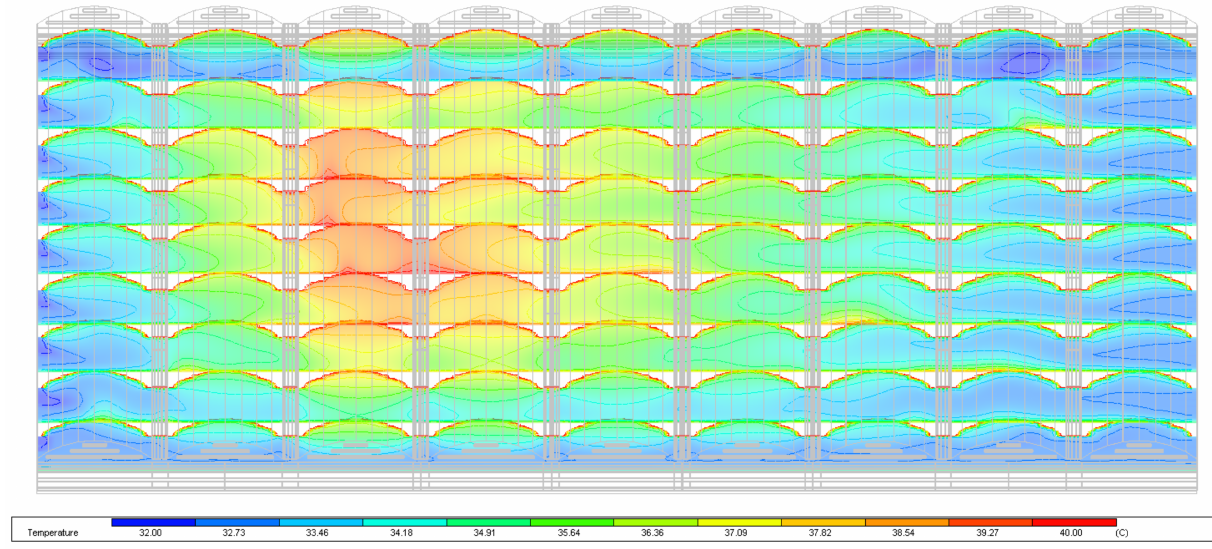
Figure 15. Temperature cloud map of the multi-span round-arch greenhouse (with an in-greenhouse ventilation channel) (outdoor wind speed 1 m/s, outdoor temperature 32.7 ◦